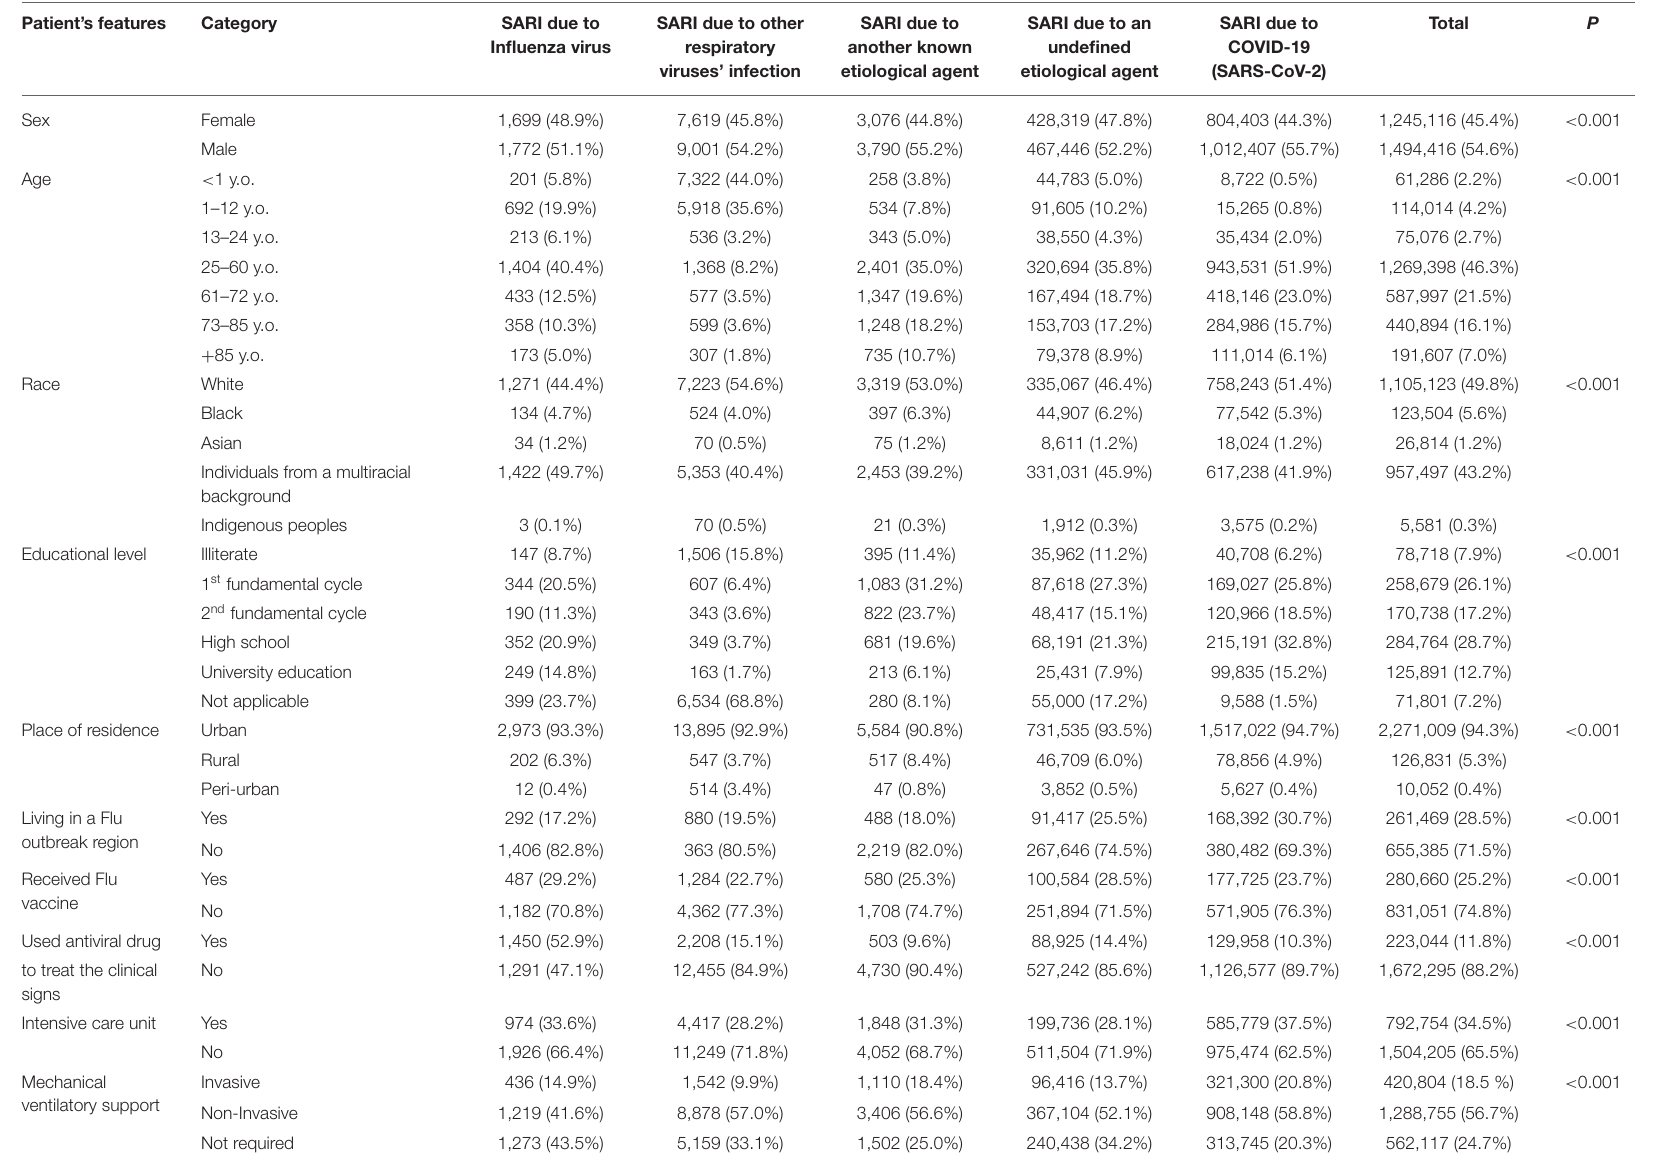
TABLE 3 | Association between the severe acute respiratory infection (SARI) categories and the features of the hospitalized patients due to SARI in Brazil during the Coronavirus Disease (COVID)-19